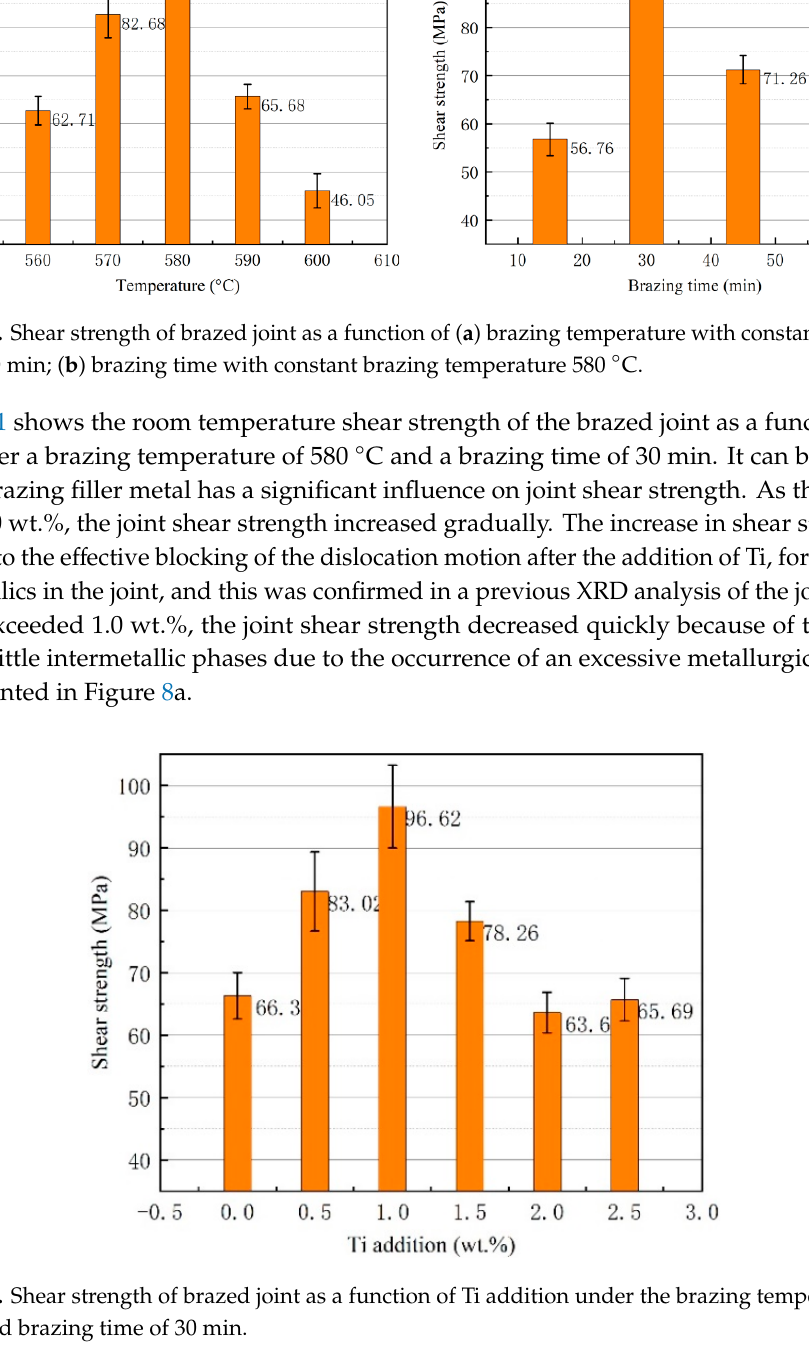
Figure 11. Shear strength of brazed joint as a function of Ti addition under the brazing temperature of 580 °C and brazing time of 30 min.